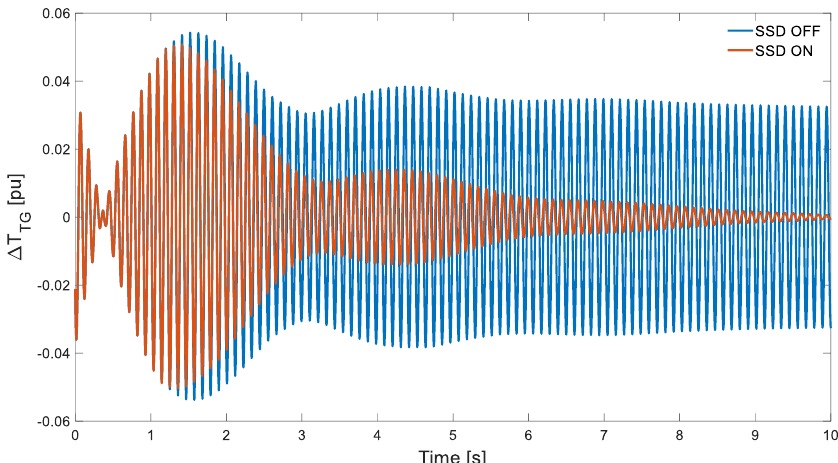
Figure 13. Torque oscillation ∆ T TG at the first TNF in configuration CC (results related to the data of